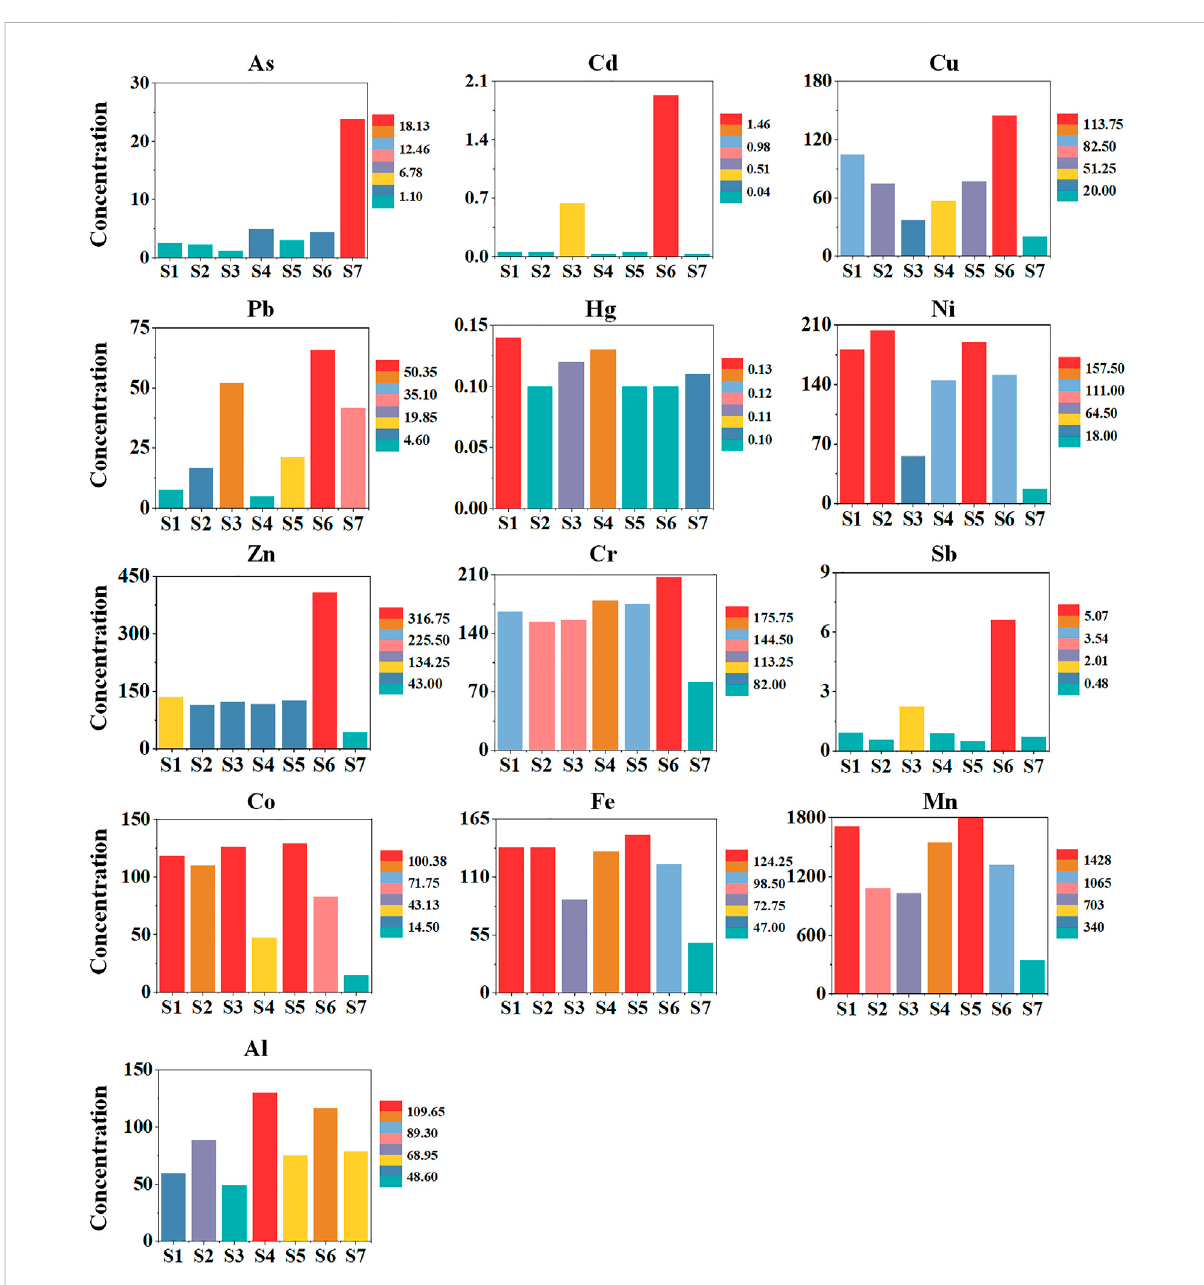
FIGURE 6 Metal concentration distribution at each sampling site (Al and Fe, unit: g · kg − 1 ; others, unit: mg · kg − 1 ; dry weight).